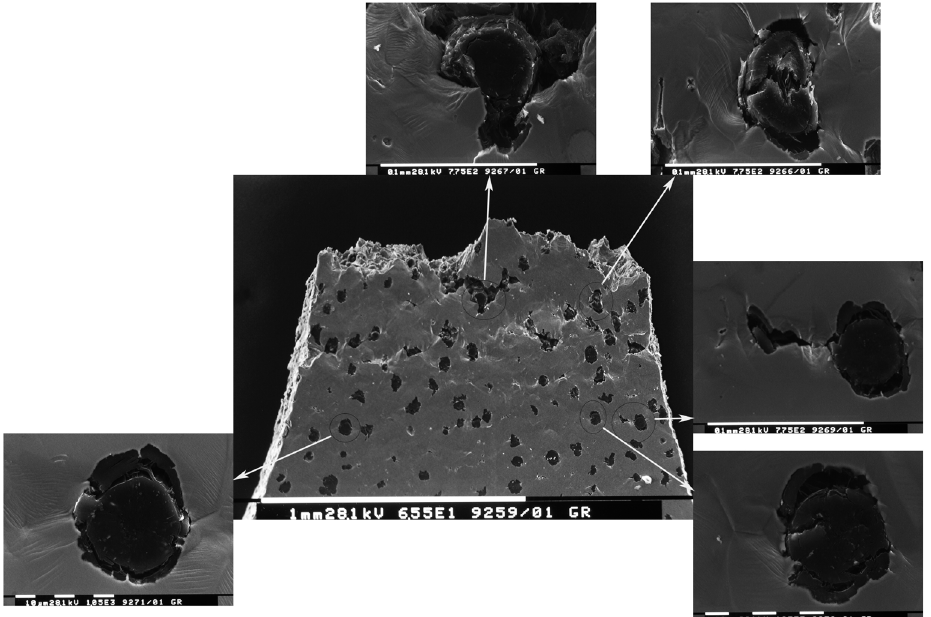
Figure 2: EN GJS350-22 ductile cast iron. Scanning Electron Microscope in situ lateral surface analysis performed on notched specimen